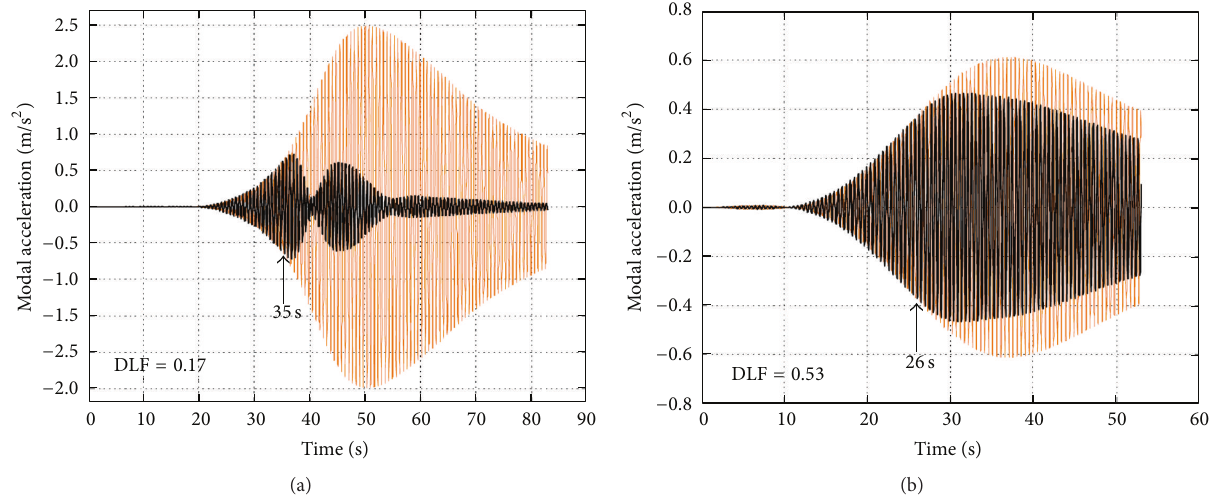
Figure 15: Simulated (orange) and measured modal responses due to free walking at resonance on (a) footbridge 1 (slow pacing rate) at first mode natural frequency of 1.52Hz and (b) footbridge 2 (fast pacing rate) at first mode natural frequency of 2.04 Hz